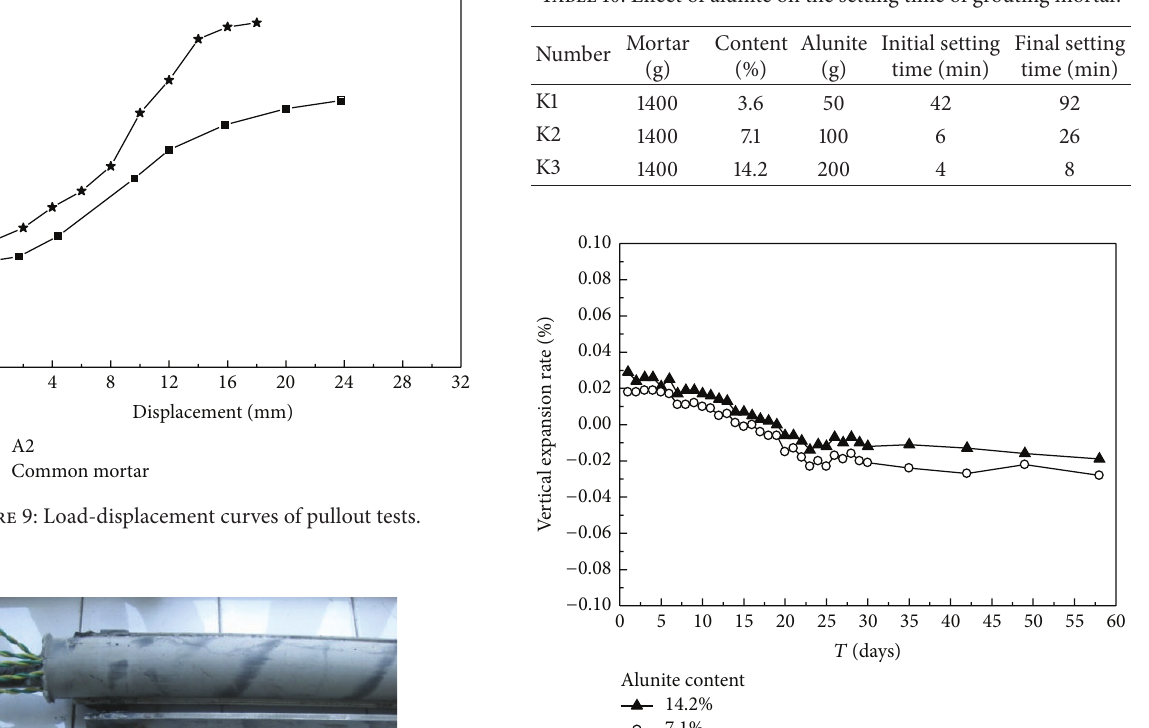
Table 10: Effect of alunite on the setting time of grouting mortar.